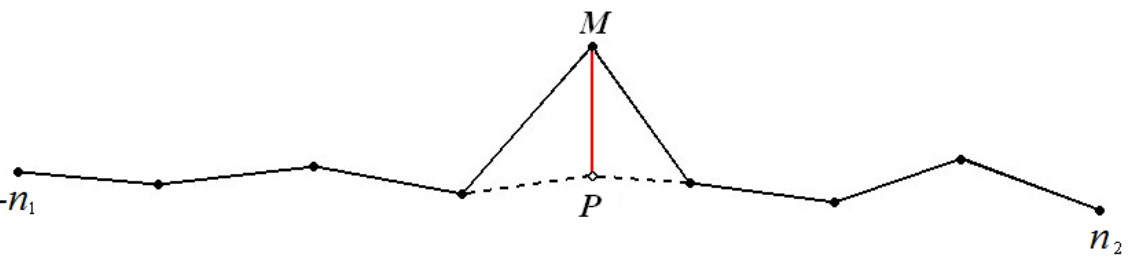
Figure 2. Time series of points used to generate predictions (P) for measured points